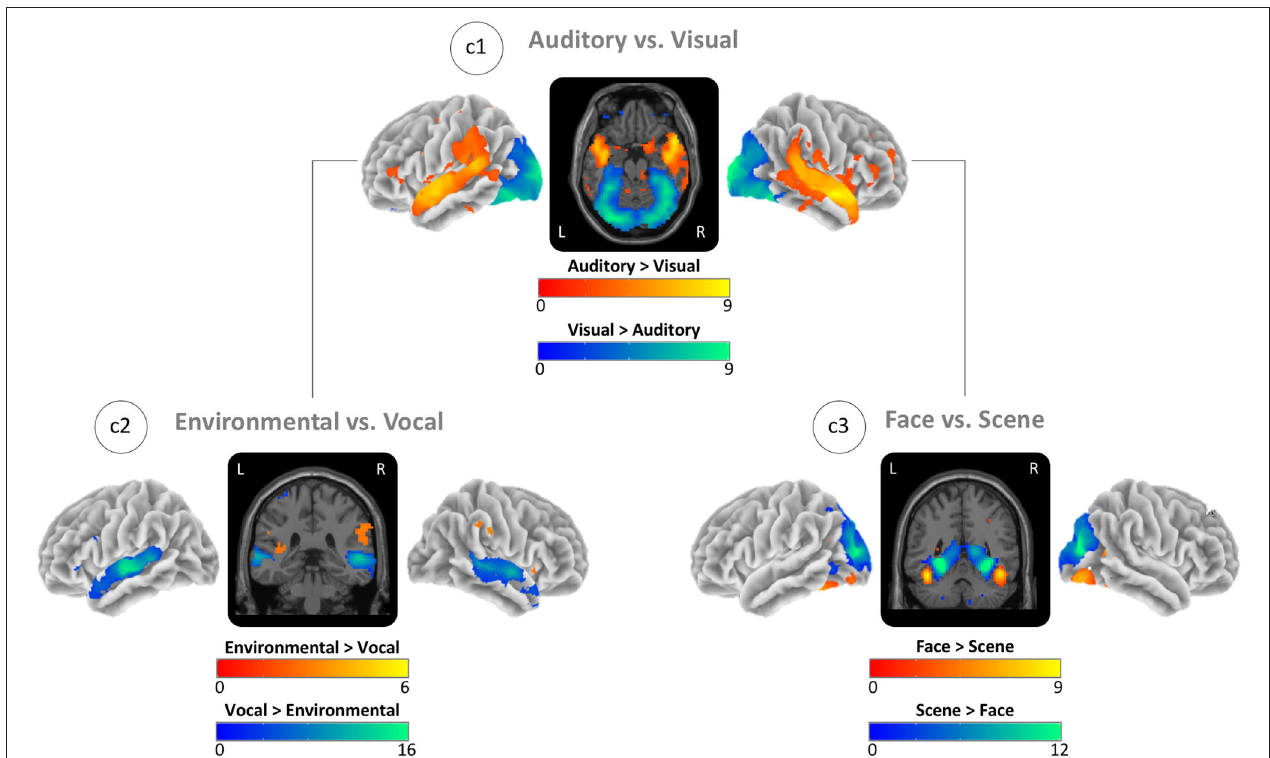
FIGURE 3 | Task-based activity contrasts between (Auditory vs. Visual) and within (Environmental vs. Vocal and Face vs. Scene) sensory conditions. (c1) Block-based contrast between auditory and visual stimulus blocks. (c2) Event-related contrast between environmental and vocal sounds masked by auditory greater visual activity (see c1). (c3) Event-related contrast between face and scene images masked by visual greater auditory activity (see c1). Brain activity is shown at a threshold of p < 0.05 [false discovery rate (FDR) corrected], and the color intensity shows the t -value. Contrast maps are uploaded under https://neurovault.org/collections/